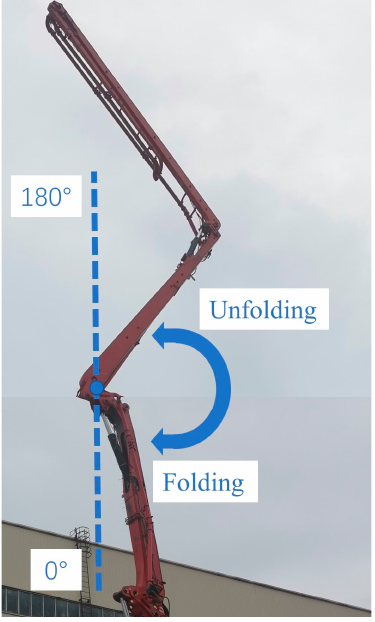
Figure 24. Movement schematic of boom section 4.